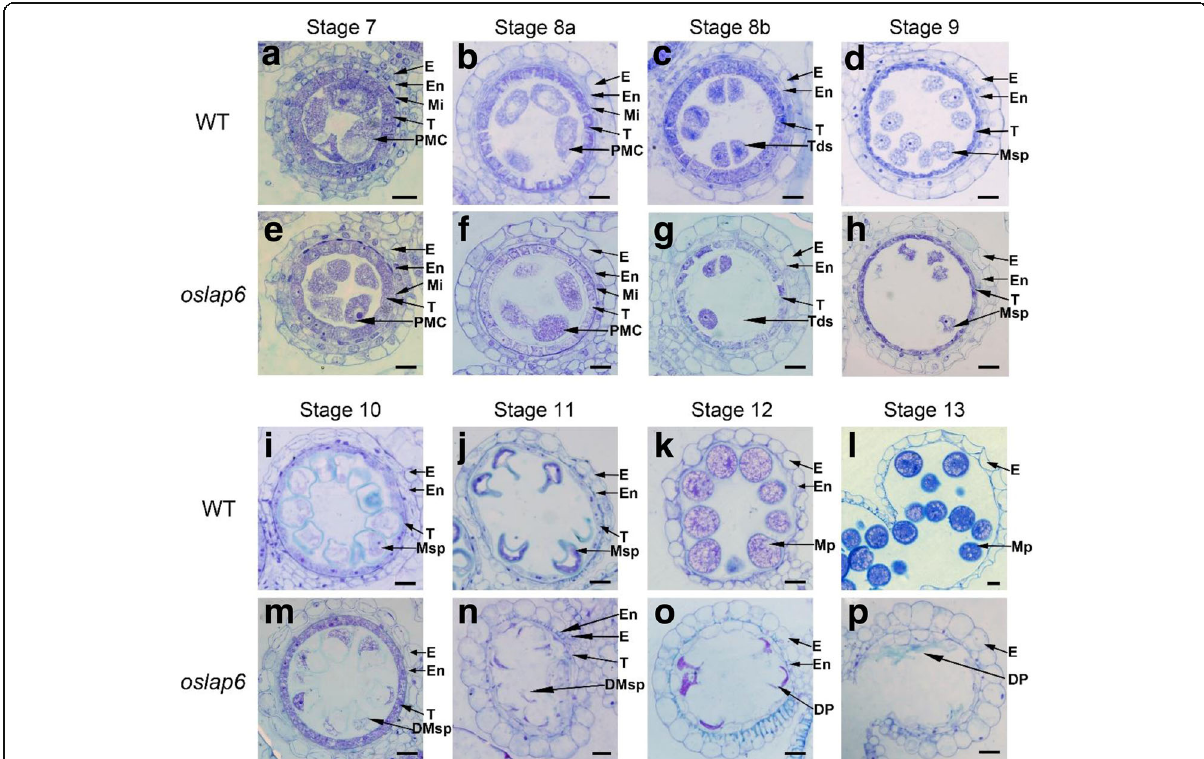
Fig. 2 Transverse section comparison of anther development between the WT and oslap6 . Eight stages of anther development between the WT and oslap6 were compared. a and e Stage 7; b and f Stage 8a; c and g Stage 8b; d and h Stage 9; i and m Stage 10; j and n Stage 11; k and o Stage 12; l and p Stage 13; the WT sections are shown in a - d and i - l ; Sections of the oslap6 are shown in e - h and m - p . DMsp, degenerated microspore; DP, degenerated pollen; E, epidermis; En, endothecium; Mi, middle layer; MP, mature pollen; Msp, microspore; PMC, pollen mother cell; Tds, tetrads; T, tapetum. Scale bars =15 μ